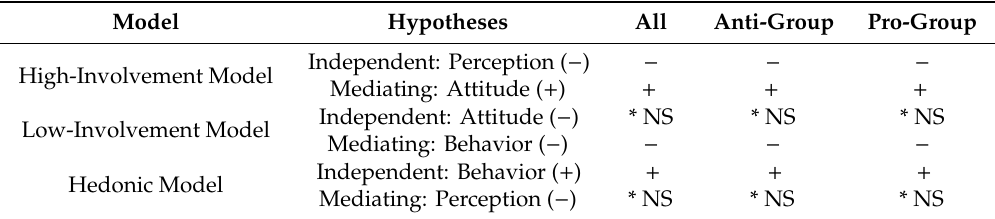
Table 10. Summary of